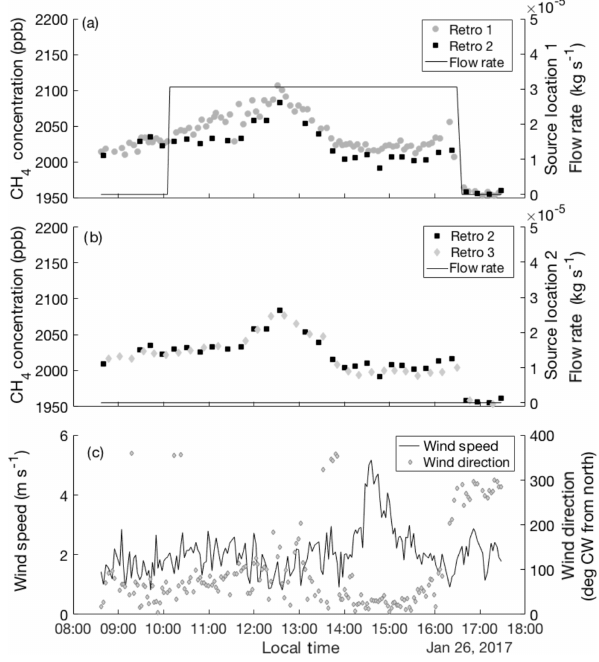
Figure 10. Line-integrated atmospheric CH 4 concentrations mea- sured on 26 January 2017 along beam paths to retroreflectors 1 and 2 (a) and to retroreflectors 2 and 3 (b) , as well as wind speed and wind direction (c) . Gray and black points and left-hand axes of panels (a) and (b) show CH 4 concentration. The black line and right-hand axis in panel (a) show the flow rate at source location 1 (bounded by retroreflectors 1 and 2) and the black line and right- hand axis in panel (b) show the flow rate at source location 2 (bounded by retroreflectors 2 and 3). In panel (c) , the black line and left-hand axis show wind speed and the gray diamonds and right-hand axis show wind direction (according to meteorological convention, 0 ◦ is north, 90 ◦ is east, 180 ◦ is south, 270 ◦ is west, and 360 ◦ is north). All data reflects 2min averaging